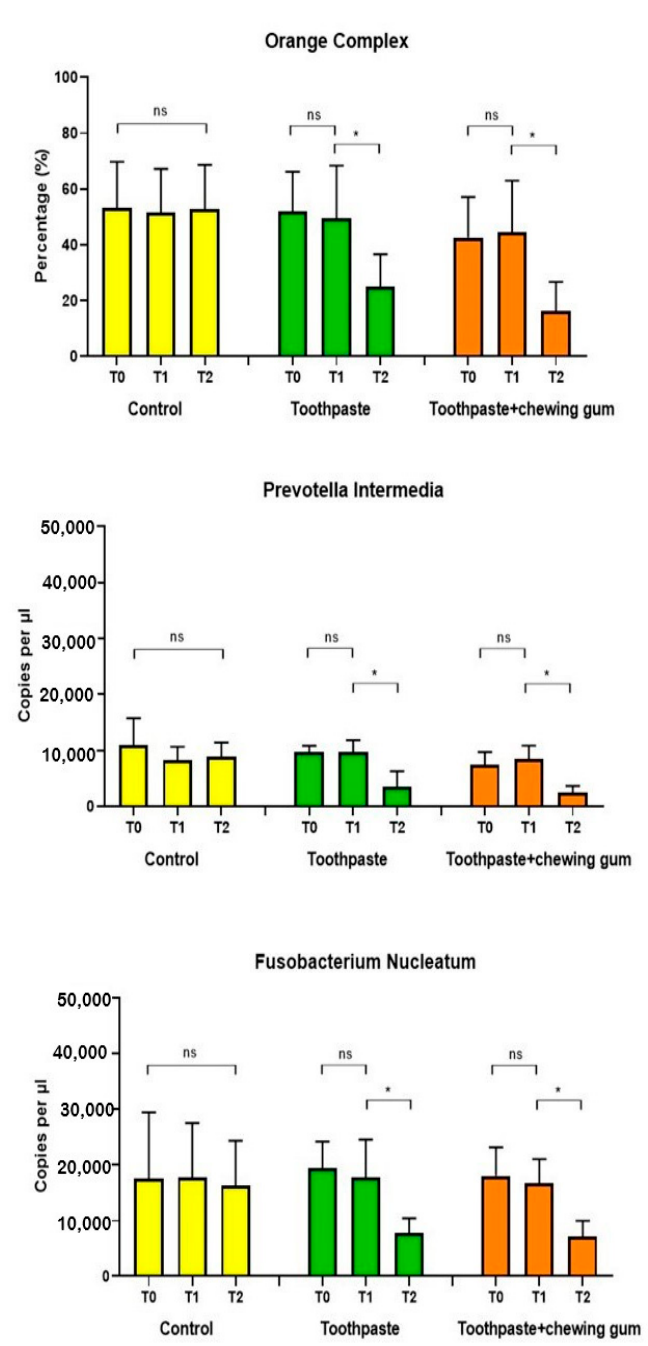
Figure 6. Orange Complex (%); Prevotella intermedia (copies/ µ L); Fusobacterium nucleatum (copies/ µ L). *: statistically significant difference ( p < 0.05); ns: not significant difference ( p > 0.05).